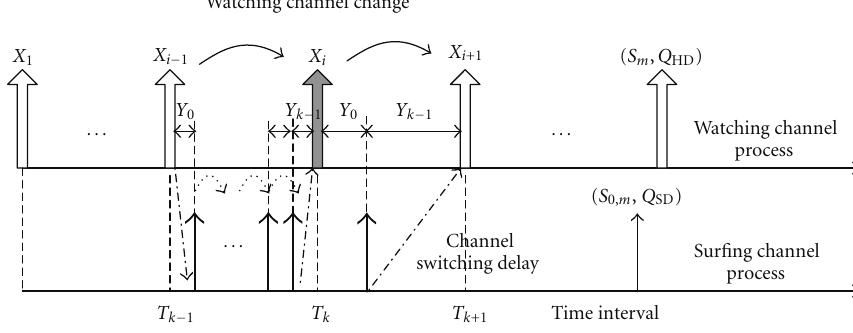
Figure 2: IPTV channel change process between watching and surfing channel